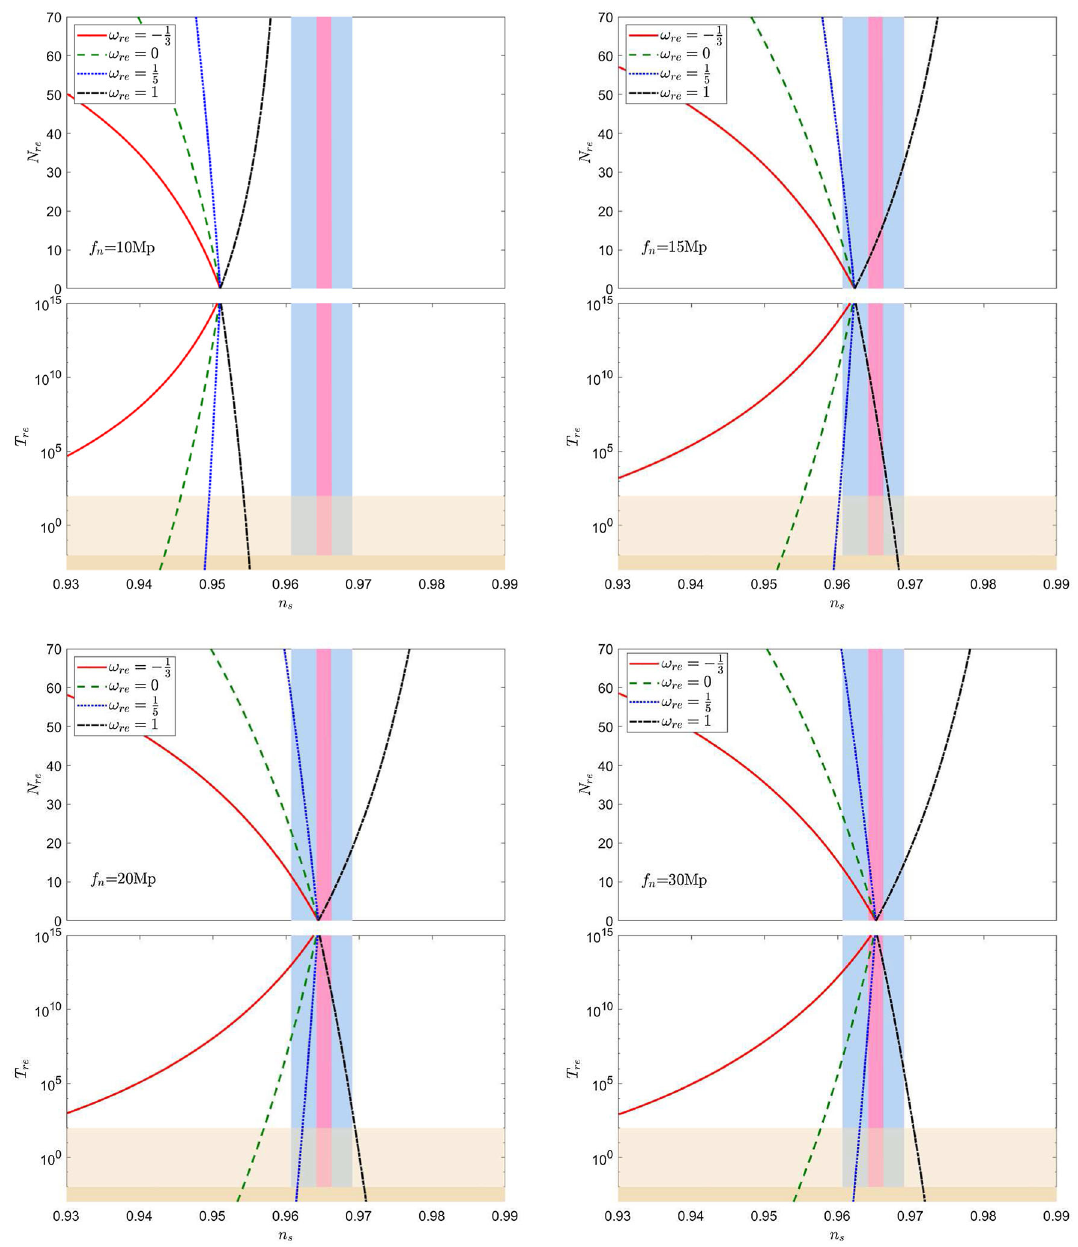
Fig. 7 T re and N re as a function of n s for different f n and ω re in the NII model. The legend of the shadow area refer to Fig. 3